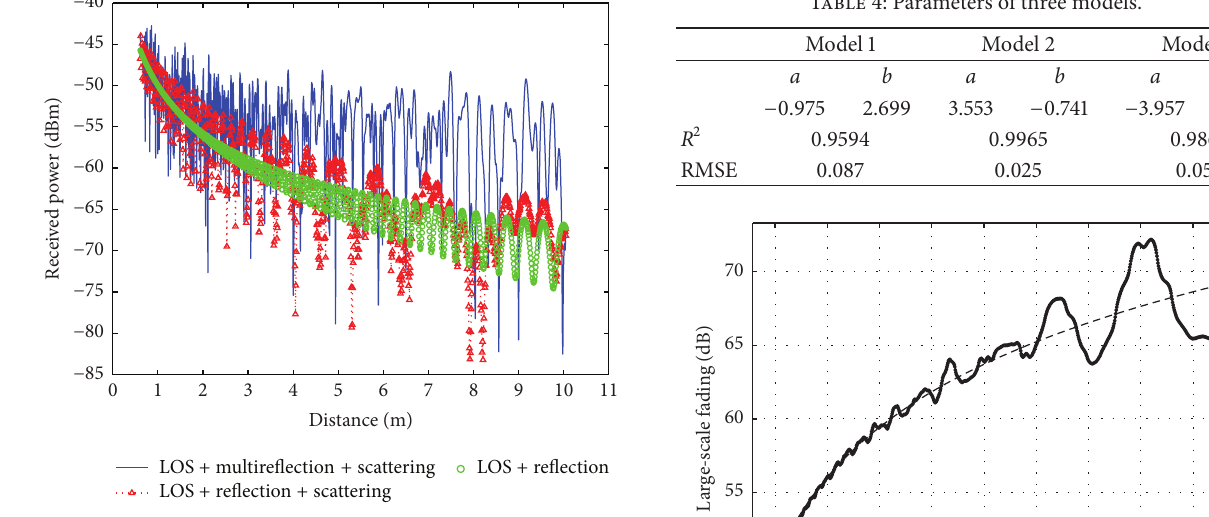
Figure 12: Simulated received power versus link distance derived from different multipath components.